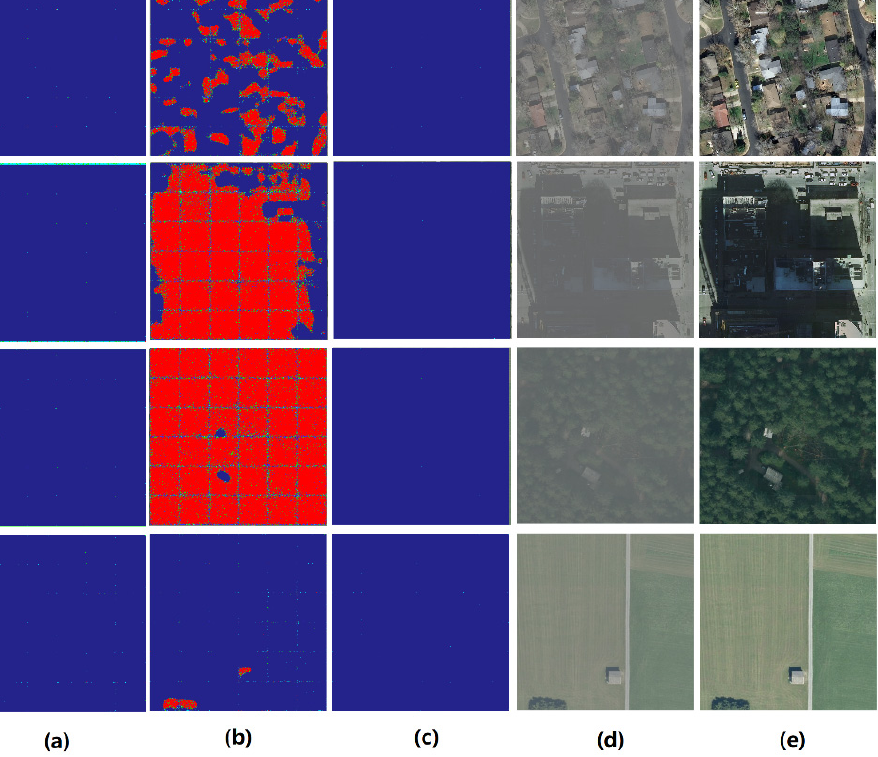
Figure 8. Two-step DRL_Dehaze results at a uniform-haze scale in various areas. ( a ) First action maps, ( b ) second action maps (at the beginning of the DRL training process), ( c ) second action maps (after the DRL training has advanced), ( d ) hazy aerial images, and ( e ) dehazed clear aerial images (action ( a ) and ( c ) maps are adopted).